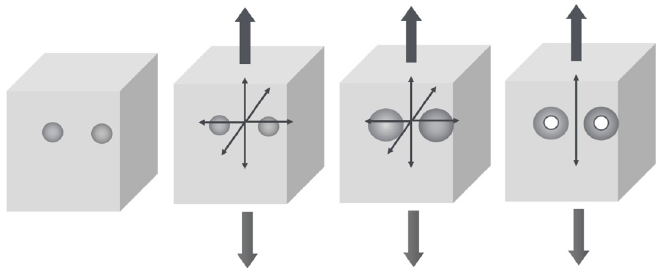
Figure 3. Schematic representation of the rubber cavitation mechanism and the concomitant plane strain–plane stress transition in the matrix ligament by the change from a negative hydrostatic stress state to a uniaxial stress state.